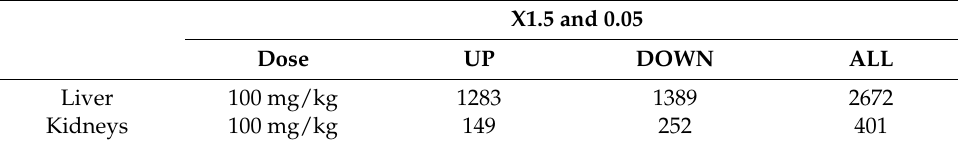
Table 6. Differentially Expressed Genes (DEGs) 1 week after treating rats with ifosfamide at 100 mg/kg bw/day.